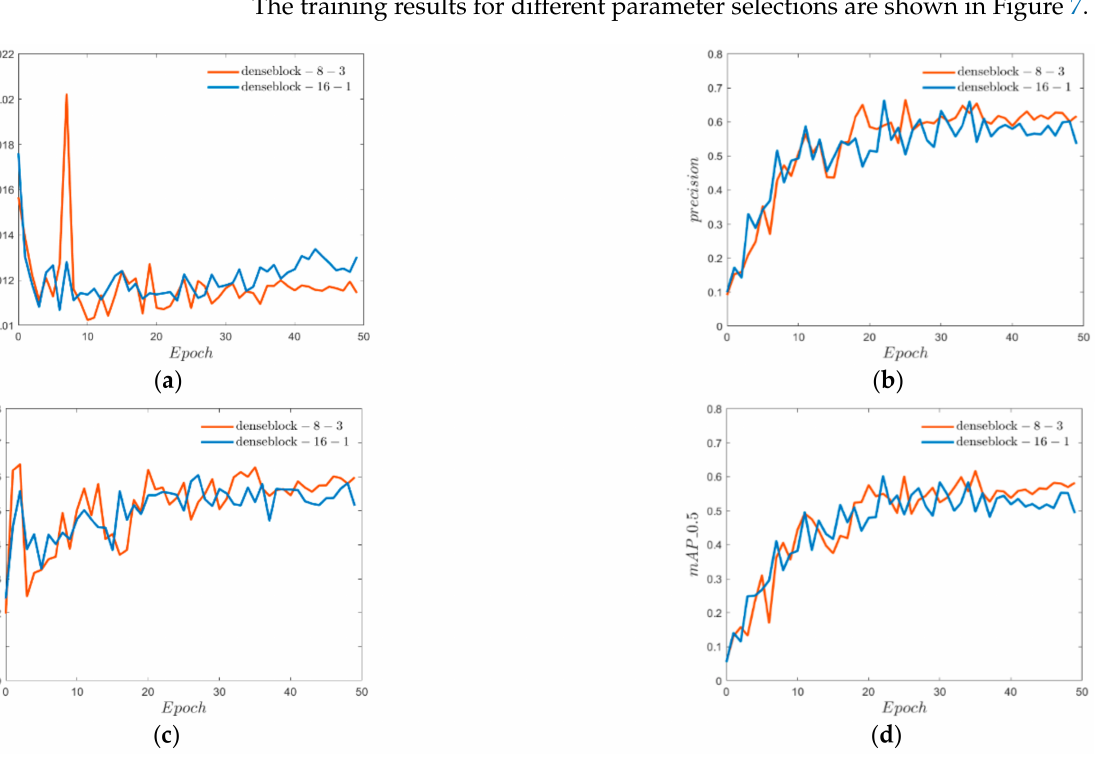
Figure 7. Comparison results of DenseBlock parameters. ( a ) Target loss. ( b ) Accuracy rate. ( c ) Recalling rate. ( d ) mAP